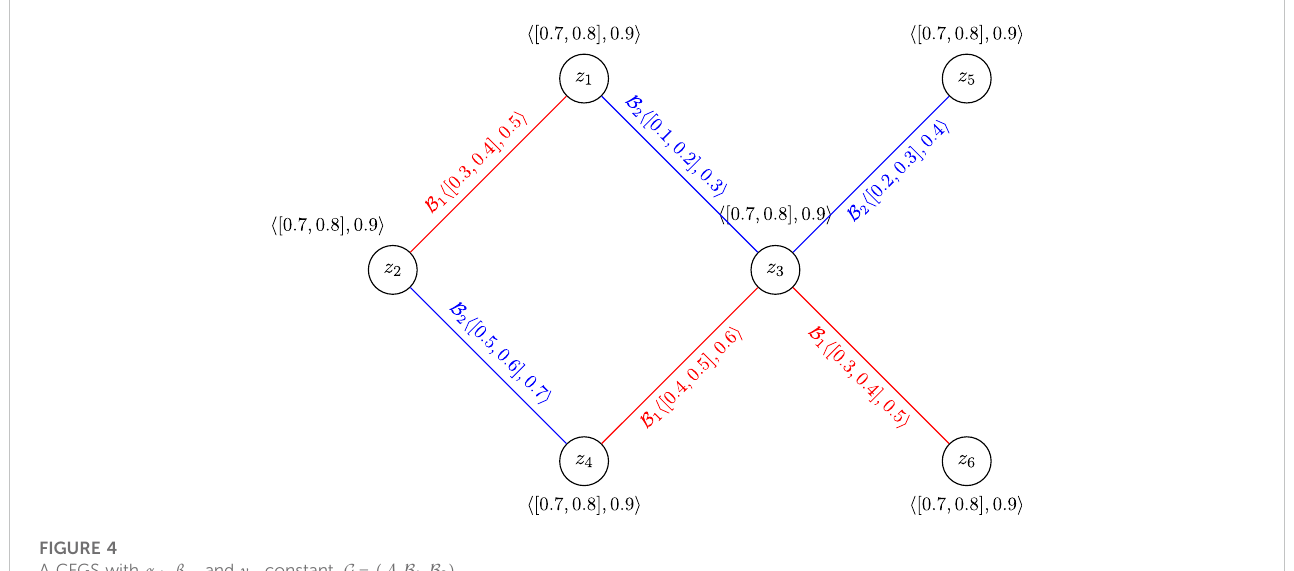
FIGURE 4 A CFGS with α A , β A , and γ A constant, G (cid:2) ( A , B 1 , B 2 )